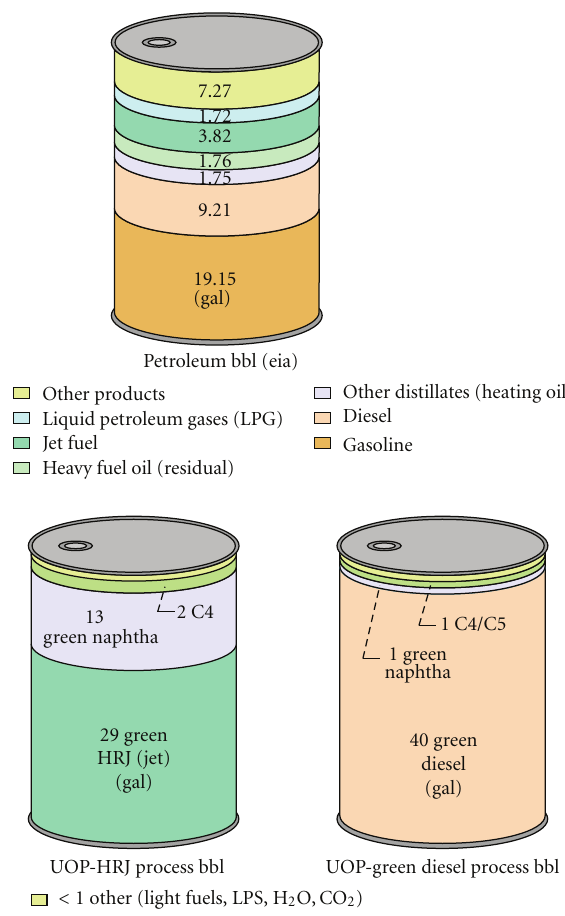
Figure 4: Gallons of distillates from a barrel of oil [13] and liquid sunshine processes UOP HRJ and green diesel [14]. potential fuel must pass is the freezing point test, − 47 ◦